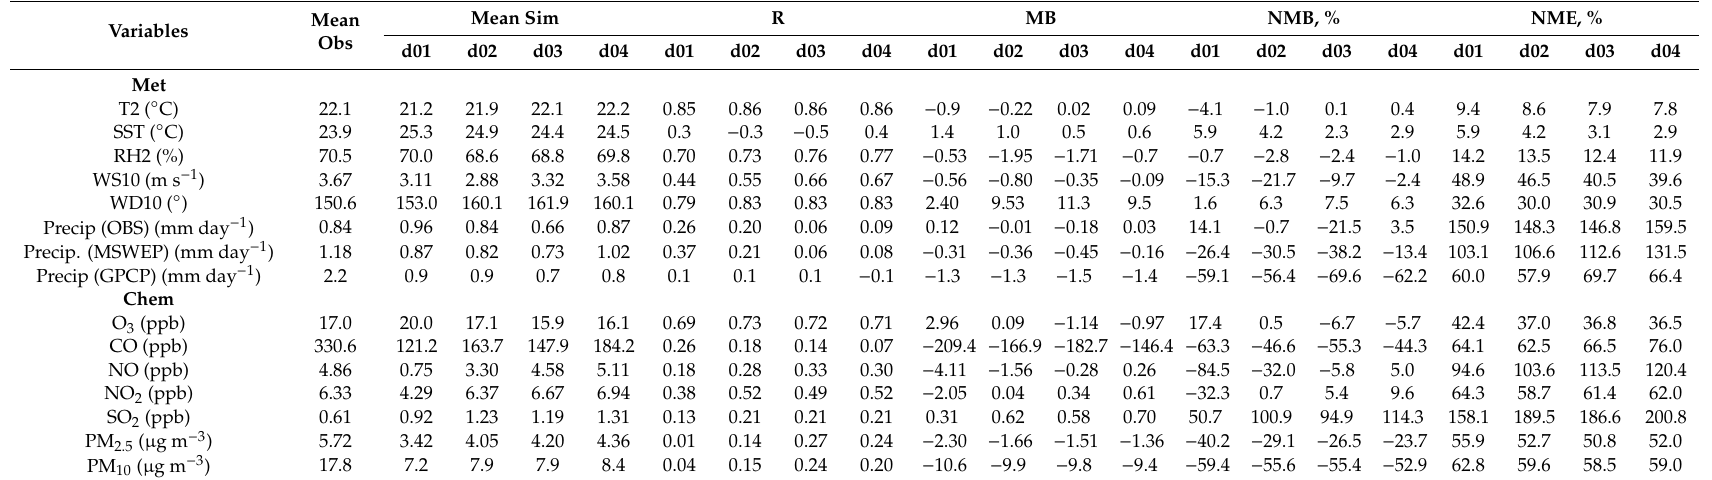
Table 1. Performance statistics of meteorological and chemical variables from WRF / Chem-ROMS simulations at a horizontal grid resolution of 81-km (in d01), 27-km (in d02), 9-km (in d03), and 3-km (in d04) calculated using predictions and observations in d04 for the SPS1 field campaign.